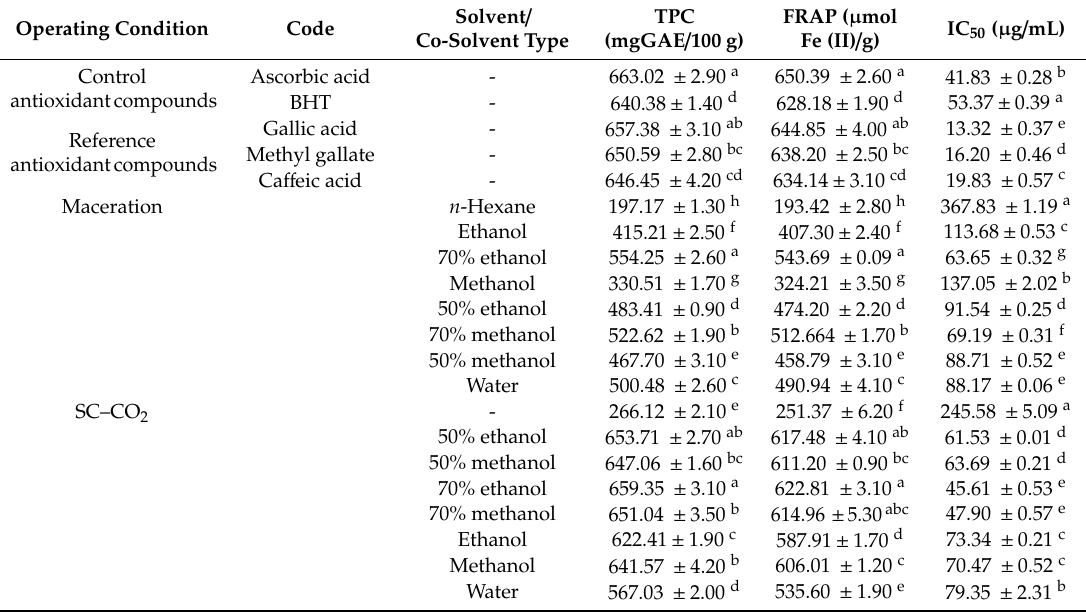
Table 3. Antioxidant capability of L. pumila extracts and the reference standards (positive